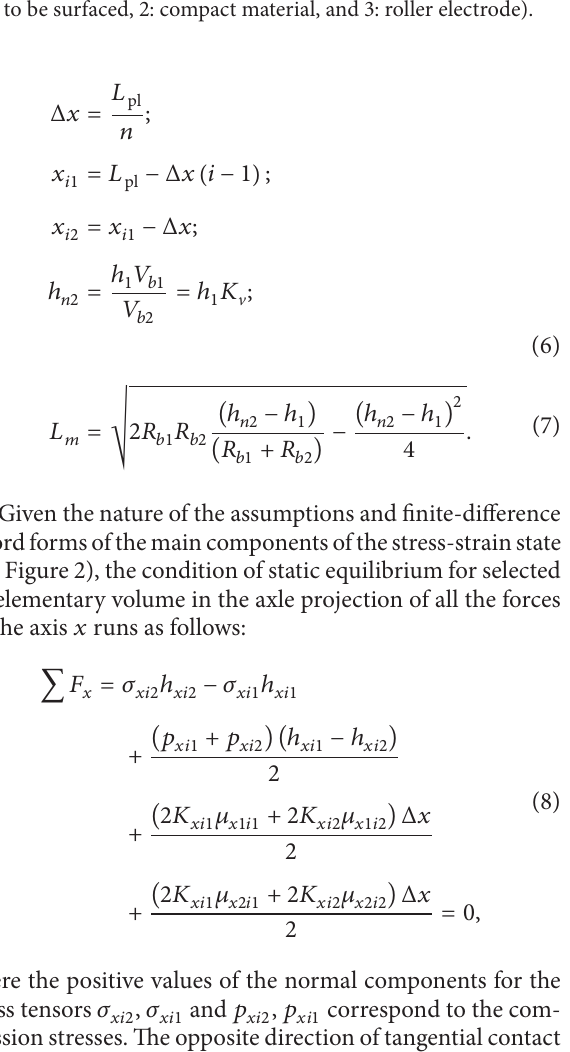
Figure 1: Design model for process of “shaft” type parts surfacing (1: part to be surfaced, 2: compact material, and 3: roller electrode).